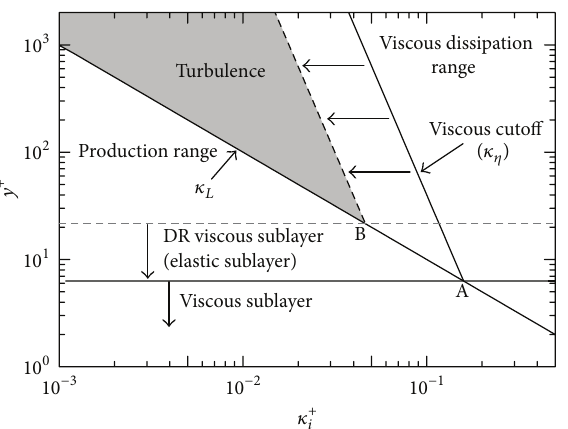
Figure 2: Scaling relation in a wall-bounded turbulence: Lumley’s concept [6].